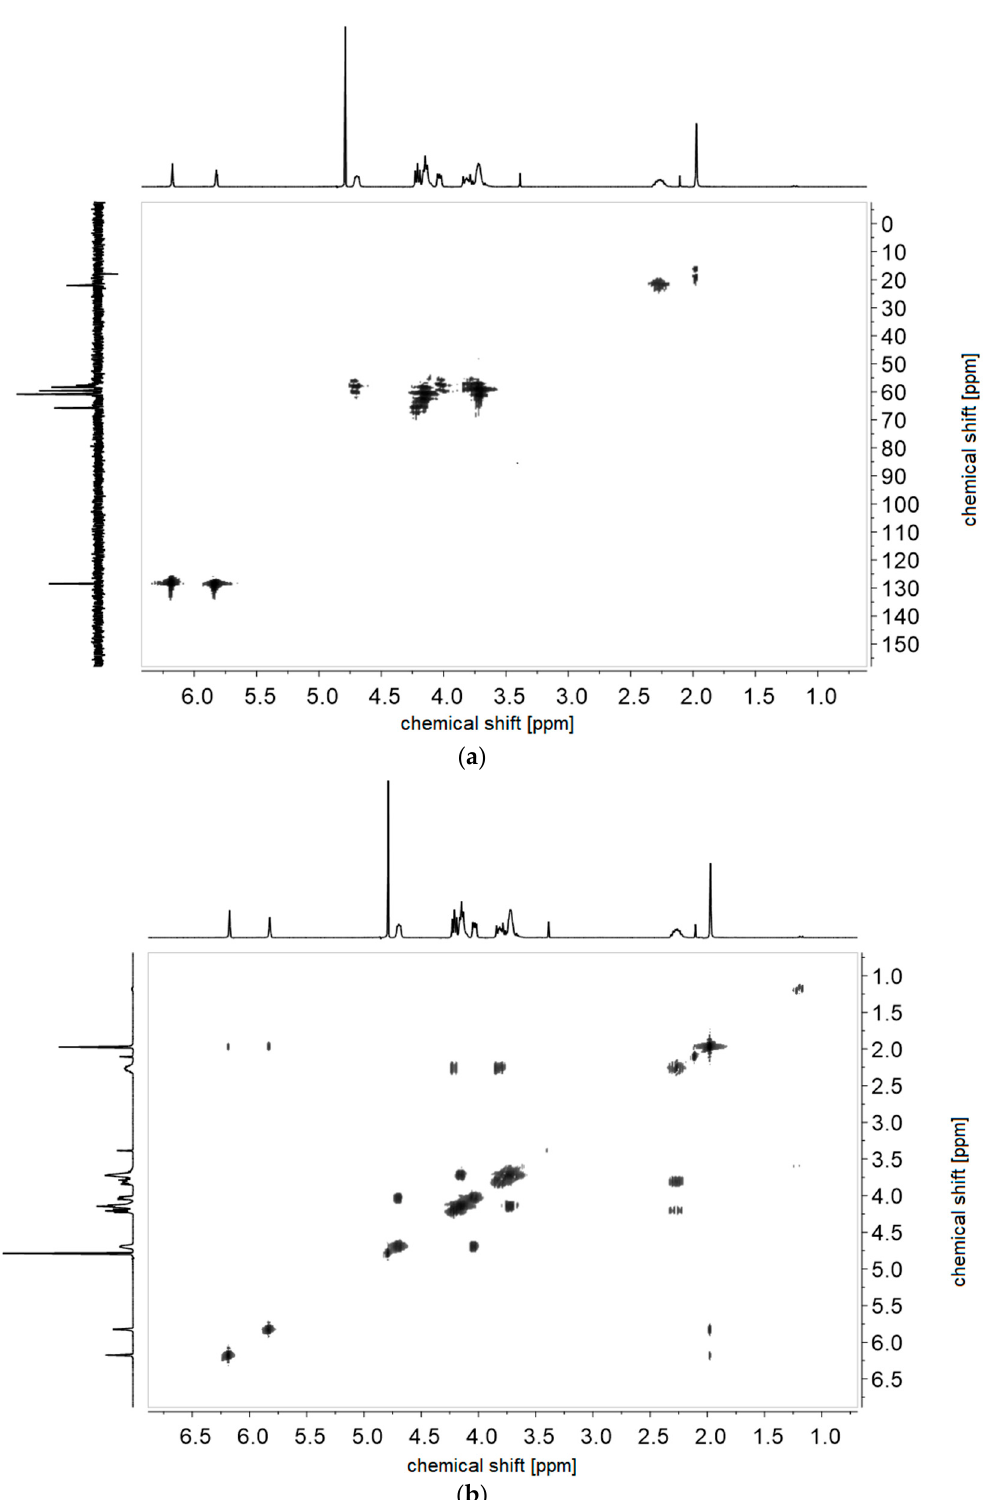
Figure A12. ( a ) 1 H- 1 H-COSY- and ( b ) 1 H- 13 C-HMQC NMR-spectra of monomer of 5d in D 2 O.